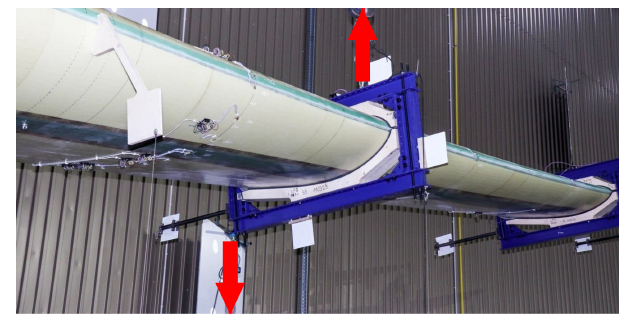
Figure 9. Configuration example of a static torsional loading on the blade with marked-up and downward-facing